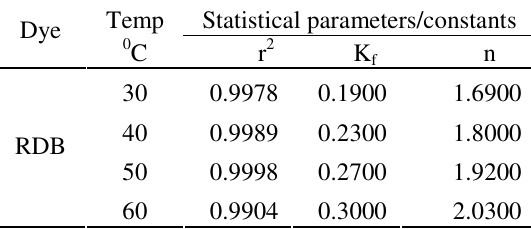
Table 5. Freundlich isotherm